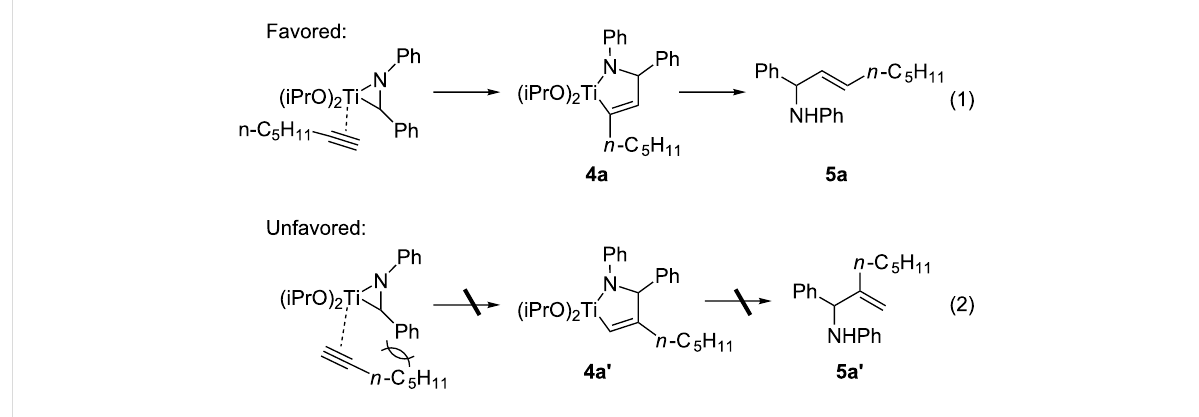
strong steric repulsion between the phenyl and pentyl groups